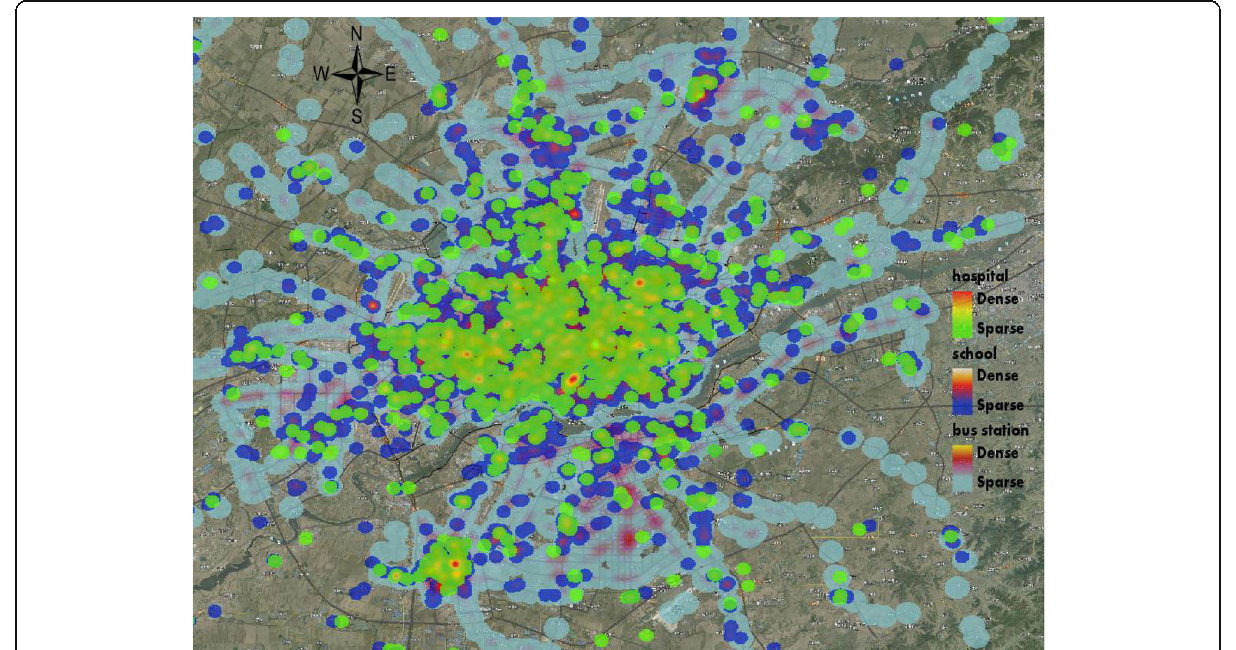
Fig. 3 Heat map of POIs including bus stations, hospitals and